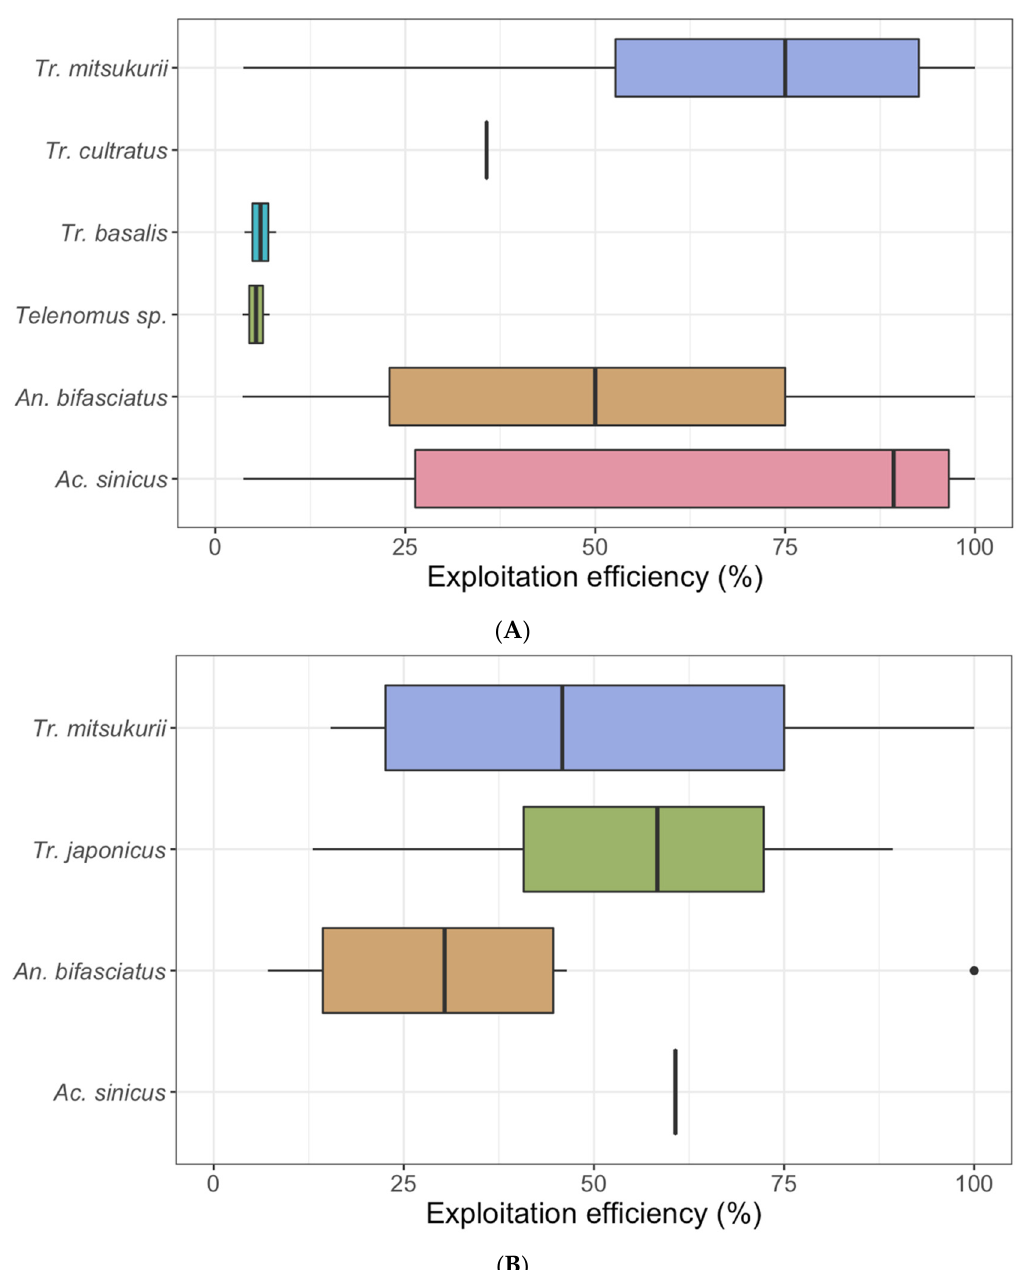
Figure 2. Boxplot of the exploitation efficiency (percentage of parasitized eggs per egg mass) for the emerged parasitoid species, from field collected egg masses ( A ) and sentinel egg masses ( B ).